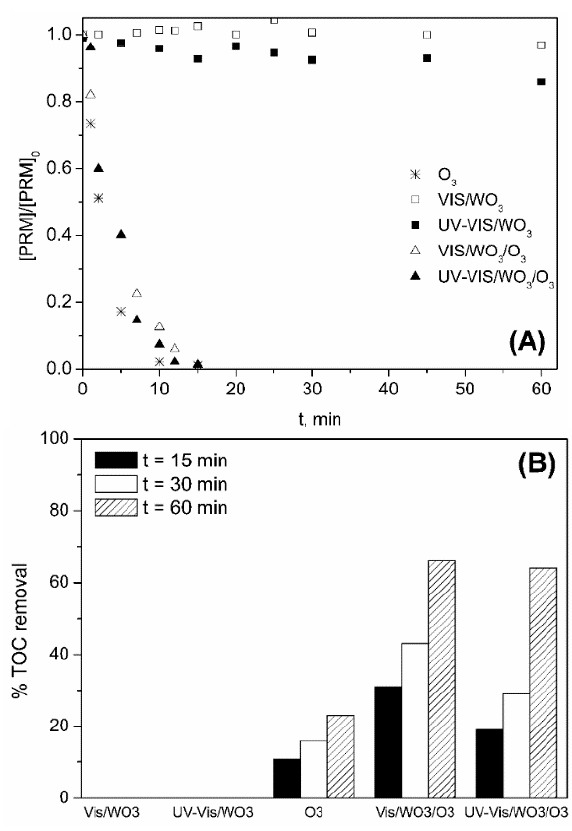
Figure 6. Variation with time of PRM normalized concentration ( A ) and percentage of TOC removed ( B ) during the application of different processes in ultrapure water. Experimental conditions: [PRM] 0 = 5 mg L − 1 ; [TOC] 0 = 3.3 mg L − 1 ; [WO 3 ] = 0.25 g L − 1 ; pH 0 ~6 (natural pH); Q m,O3 = 3.3 mg min − 1 ; T = 20–30 °C; I Vis = 7.75 × 10 − 5 Einstein L − 1 s − 1 ; I UV-Vis = 8.2 × 10 − 5 Einstein L − 1 s − 1 .